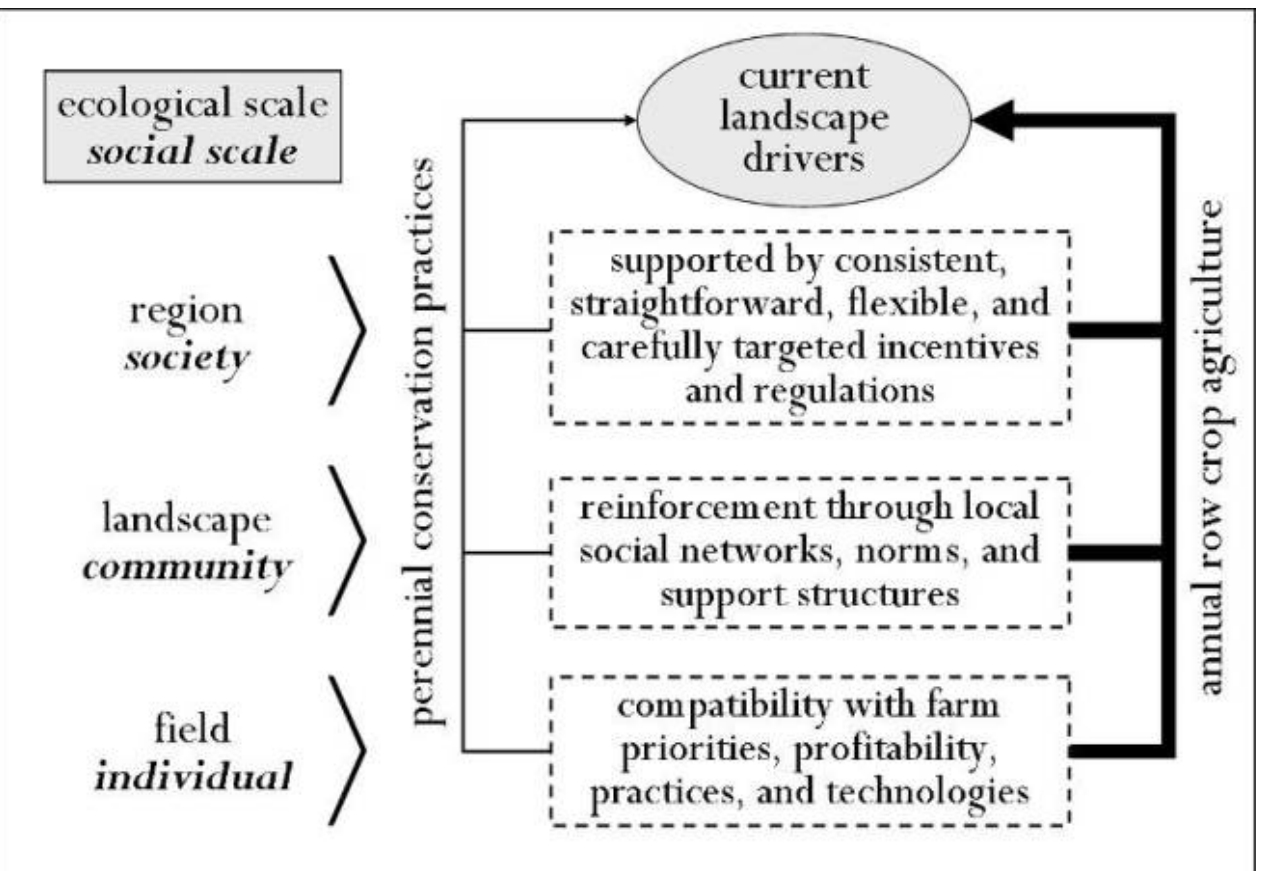
Fig. 2 . Analysis of interview data reveals a correspondence between three key biophysical scales and overlapping social scales (Atwell 2008). Corn Belt social-ecological systems are configured at multiple scales with a strong infrastructure to support increased row crop production while providing only a fraction of the comparable support for conservation practices. Analysis of the responses of our interview subjects shows that successful diffusion of perennial conservation practices must consider the social- ecological context surrounding practices at multiple scales including: consistent, straightforward, flexible, and carefully targeted incentives and regulations; reinforcement through social networks, norms, and support structures; and compatibility with farm priorities, profitability, practices, and technologies. These are many of the same factors that are currently arranged to support increased row crop production of corn and